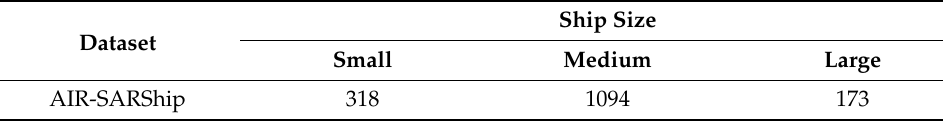
Table 5. Statistical results of multiscale ships in AIR-SARShip.